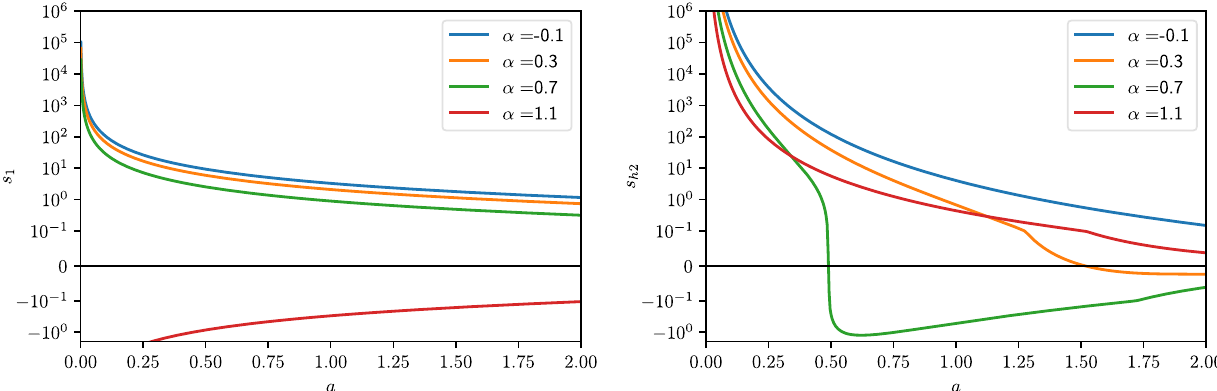
Fig. 1 Model M 1 : s 1 and s h 2 as function of scale factor for some values of α . We have used a mixed log-linear scale in order to view both asymptotic behaviour and zero crossing